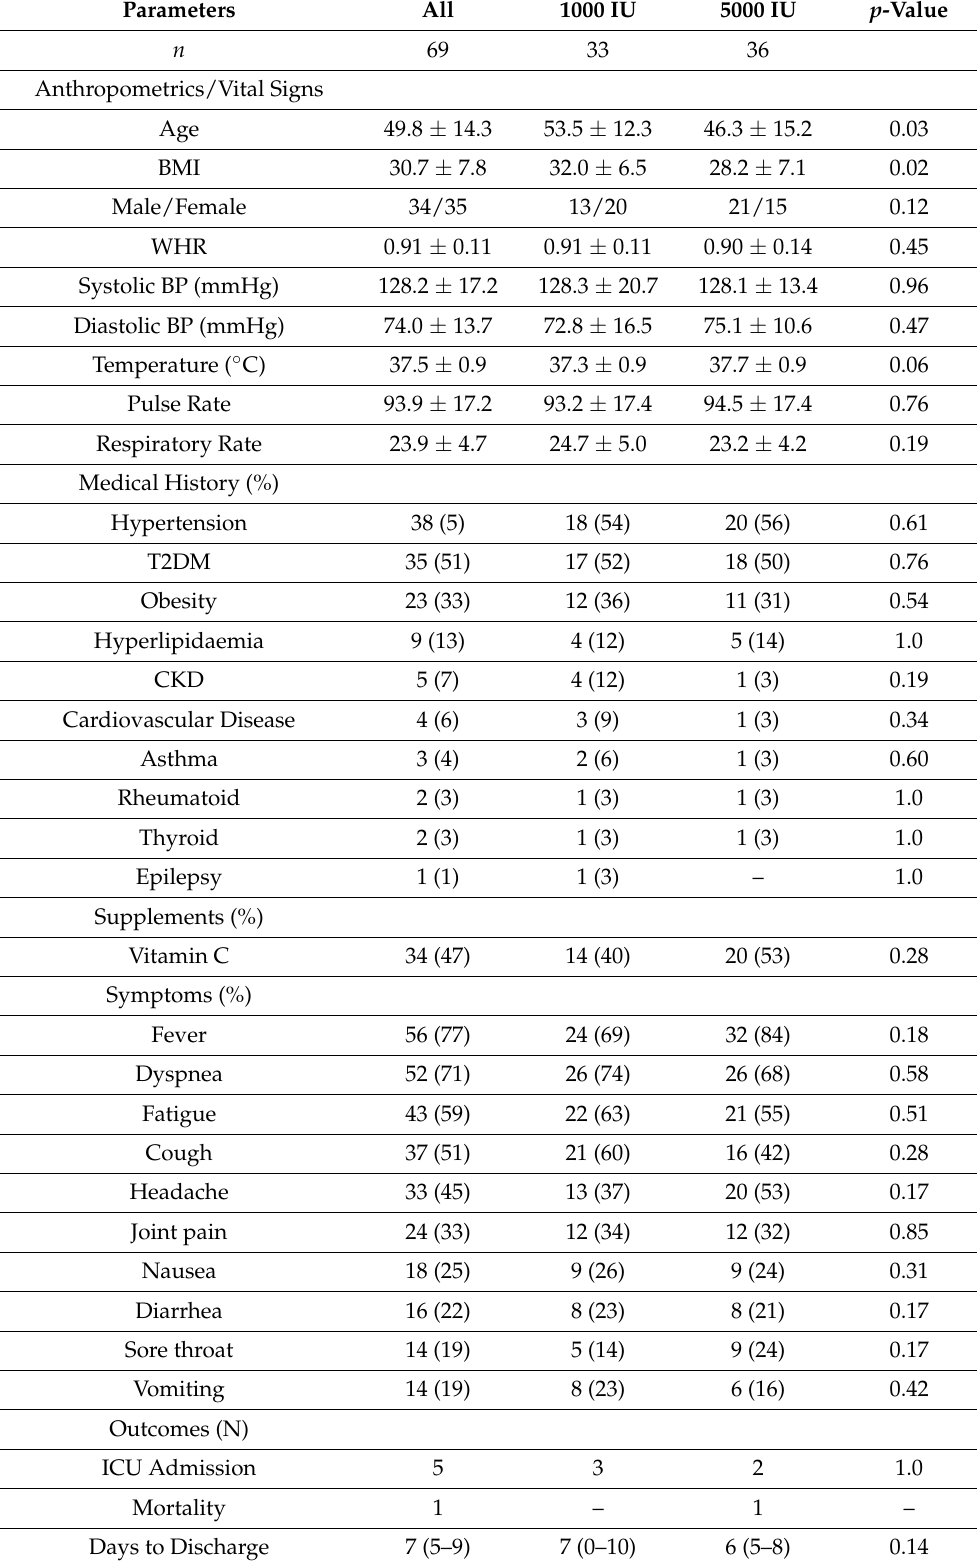
Table 1. Baseline Descriptive Characteristics and Symptoms on